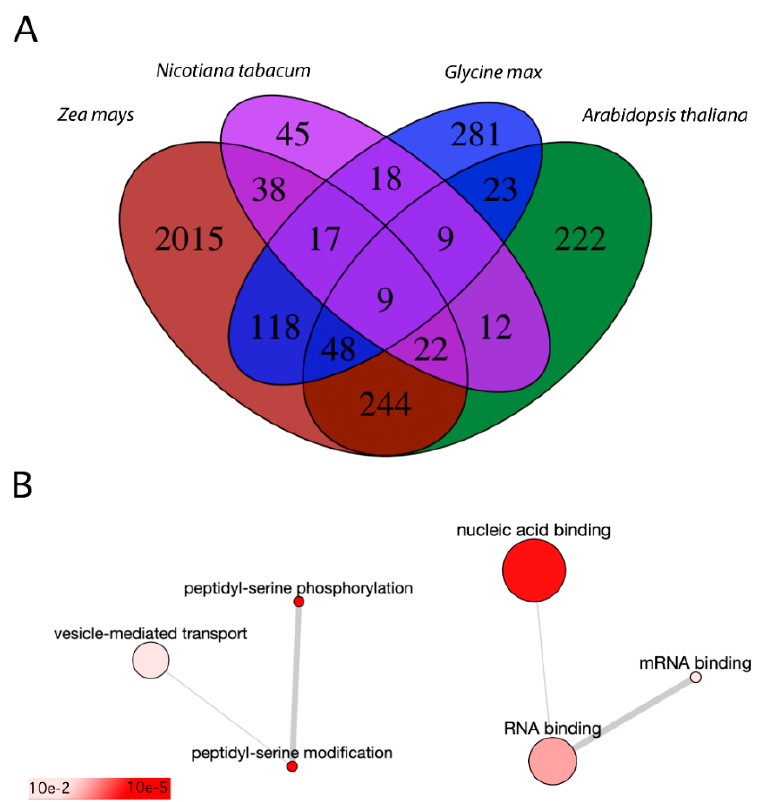
Figure 2. Comparison of pollen phosphoproteomes with root hair phosphoproteome. ( A )—Venn diagram shows the overlap of several Arabidopsis homologue phosphoproteins discovered in pollen samples of Arabidopsis (Arabidopsis thaliana) , maize ( Zea mays ), and tobacco ( Nicotiana tabacum ) together with soybean ( Glycine max ) root hair phosphoproteome. ( B )—The biological processes (left) and molecular function (right) GO terms of phosphoproteins shared between the Arabidopsis pollen phosphoproteome and soybean root hair phosphoproteome. The colour represents false discovery rate of the enriched term. The plots were rendered by Revigo [46].